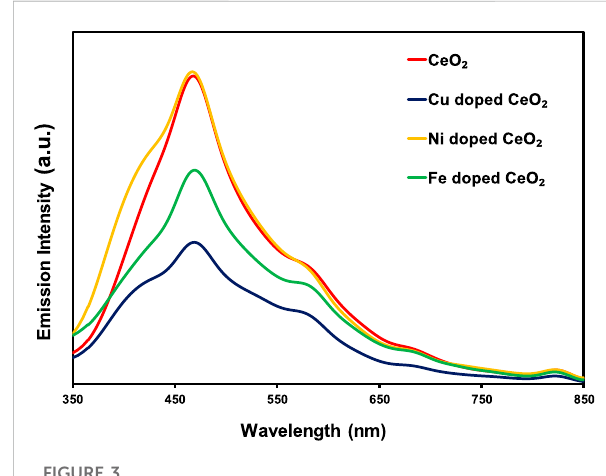
FIGURE 3 The comparison of PL spectra of pristine CeO 2 and doped CeO 2 .